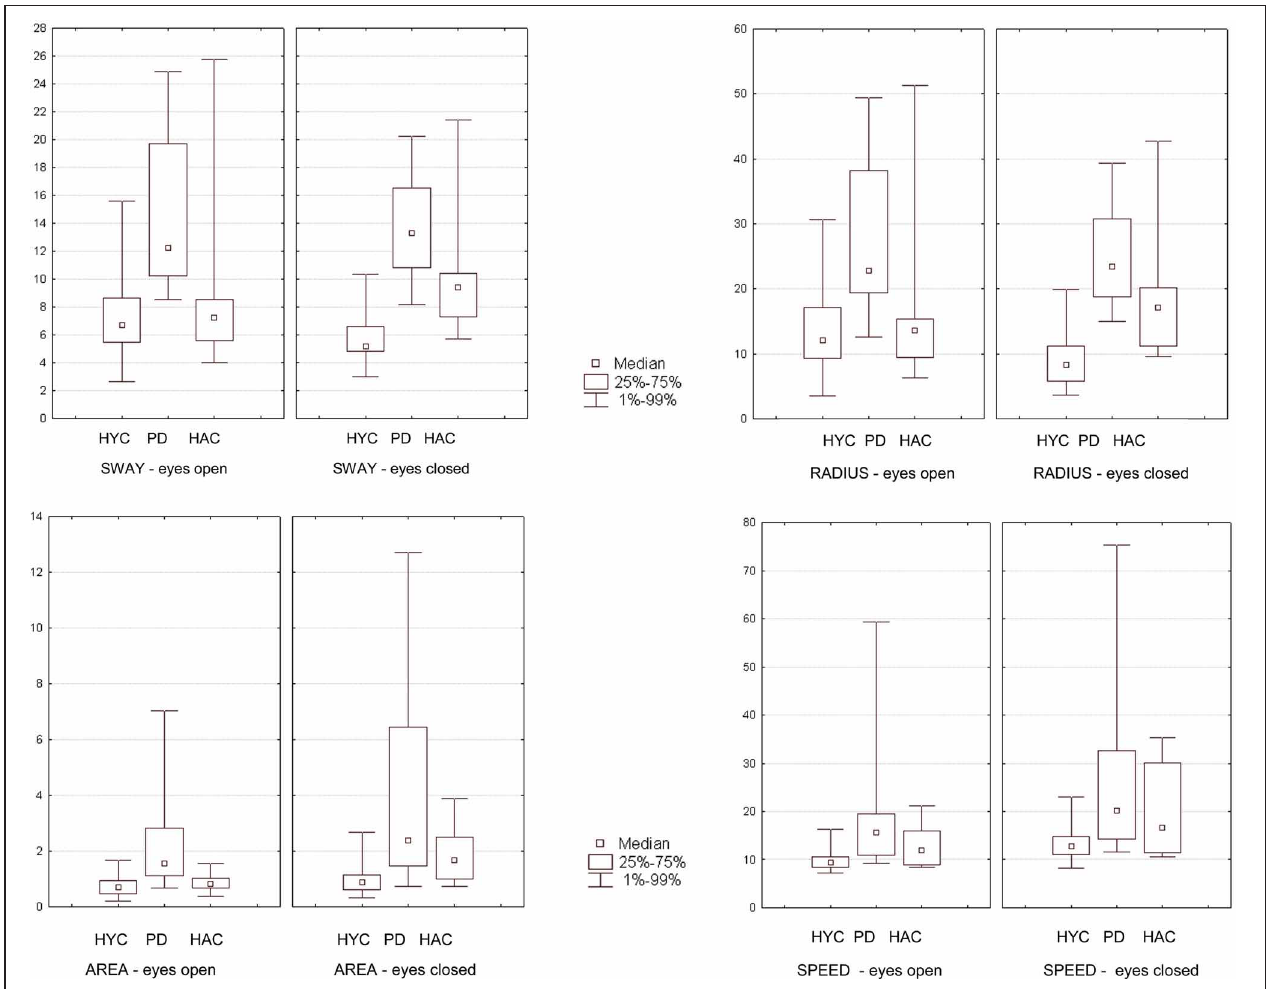
FIGURE 3 | The results of the group comparison in the Romberg-test with eyes open and eyes closed are presented graphically as box plots (HYC = healthy young control; PD = patients with Parkinson’s disease; HAC = healthy adult control). Statistical significant findings are seen especially with closed